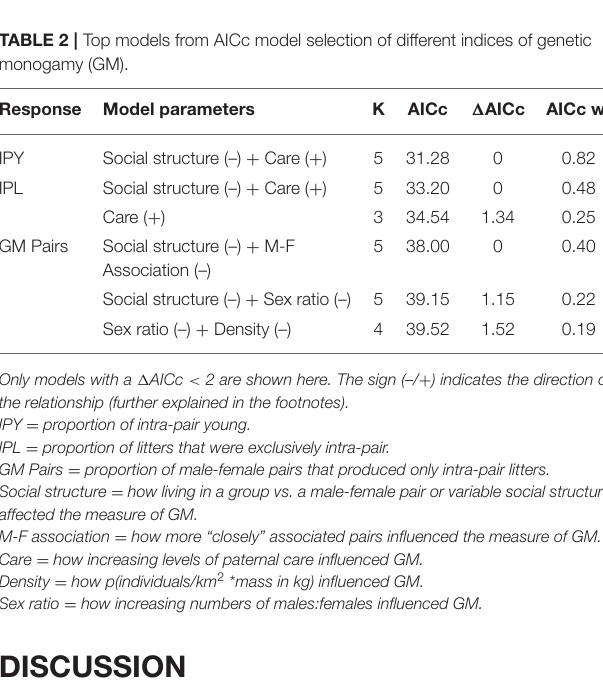
TABLE 2 | Top models from AICc model selection of different indices of genetic monogamy